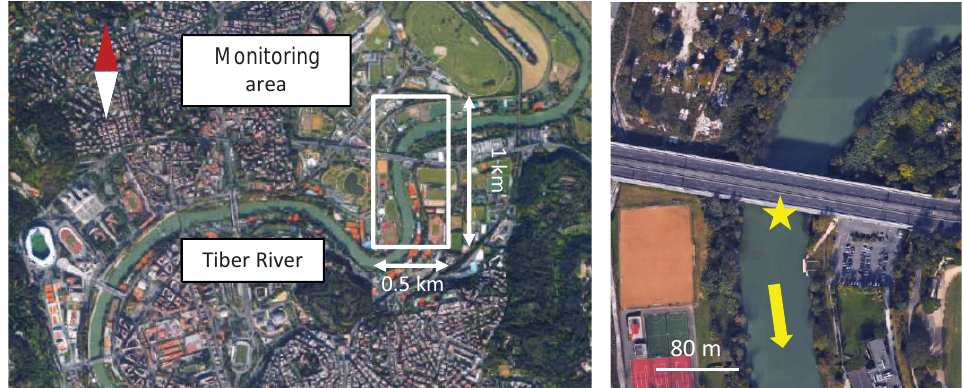
Figure 1. Left: view of the urban tract of the Tiber River – the white box encloses Ponte del Foro Italico. Right: close-up view of the measurement site – the yellow star indicates the location of the gauge-cam station and the yellow arrow shows river flow